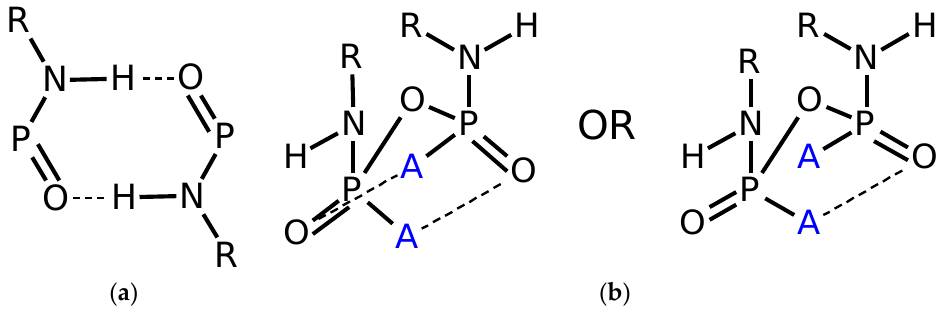
Figure 3. H-bonding synthons in P2 1 /c structures: ( a ) intermolecular ring synthon; ( b) the two variants of the intramolecular synthon where A is the non-intermolecular bonding amine (all generated using ChemSketch [24]).